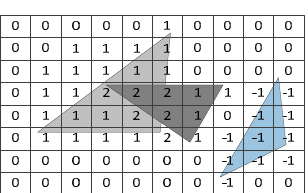
Figure 6. Estimate the location of the unknown node.